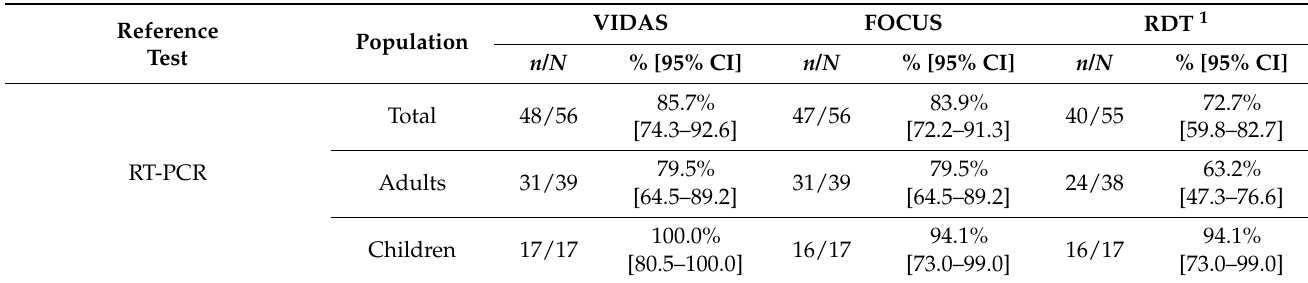
Table 2. Positive agreement of the respective NS1 antigen assays with